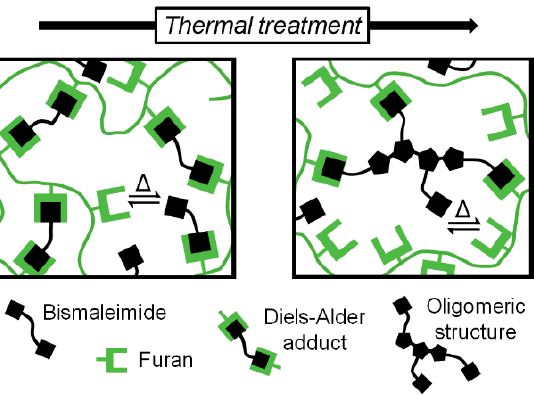
Figure 6. Polymer architecture before and after inducing maleimide self-reaction through heat.